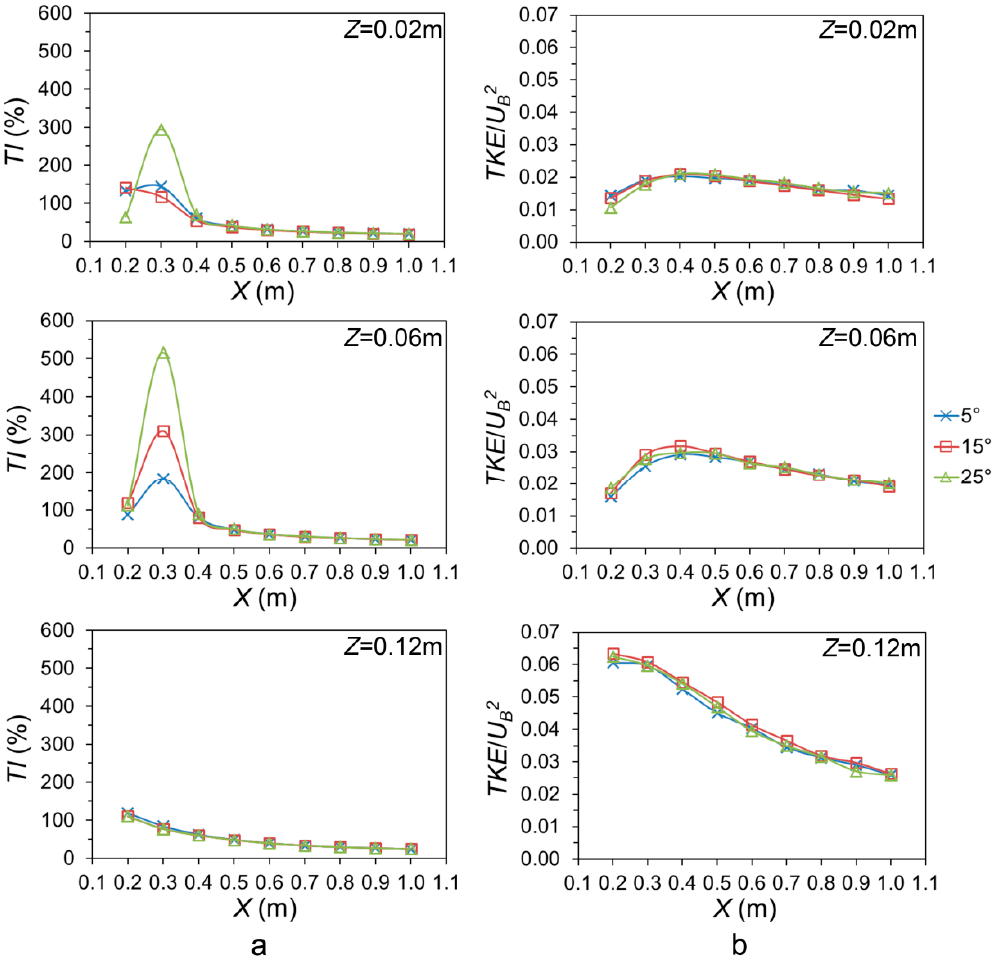
Figure 13. TI ( a ) and TKE / U B 2 ( b ) variations with respect to the distance to the building ( X ) at heights ( Z ) of 0.02 m, 0.06 m, and 0.12 m for roof slopes of 5°, 15°, and 25°.